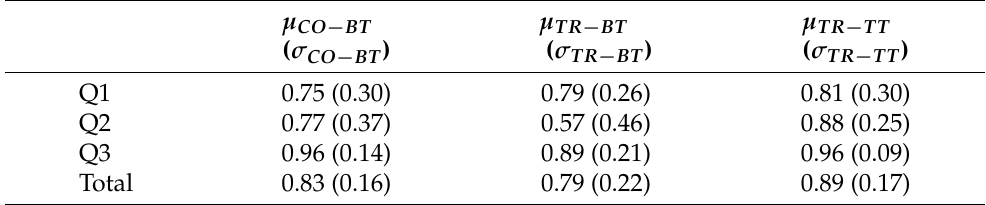
Table 2. Recorded weighted mean scores and standard deviation by question and total score (rounded to the nearest 2-decimal place).